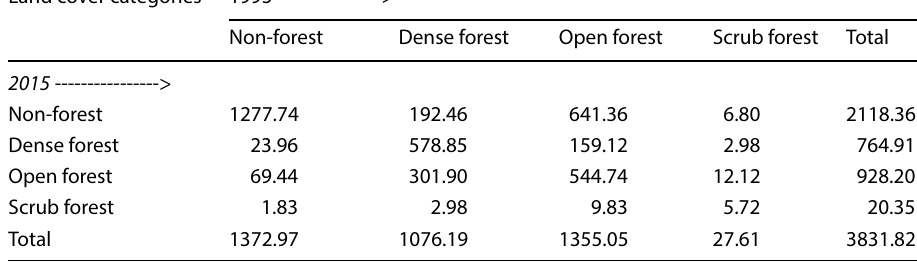
Table 6 Change matrix on land cover between the year 1995 and 2015